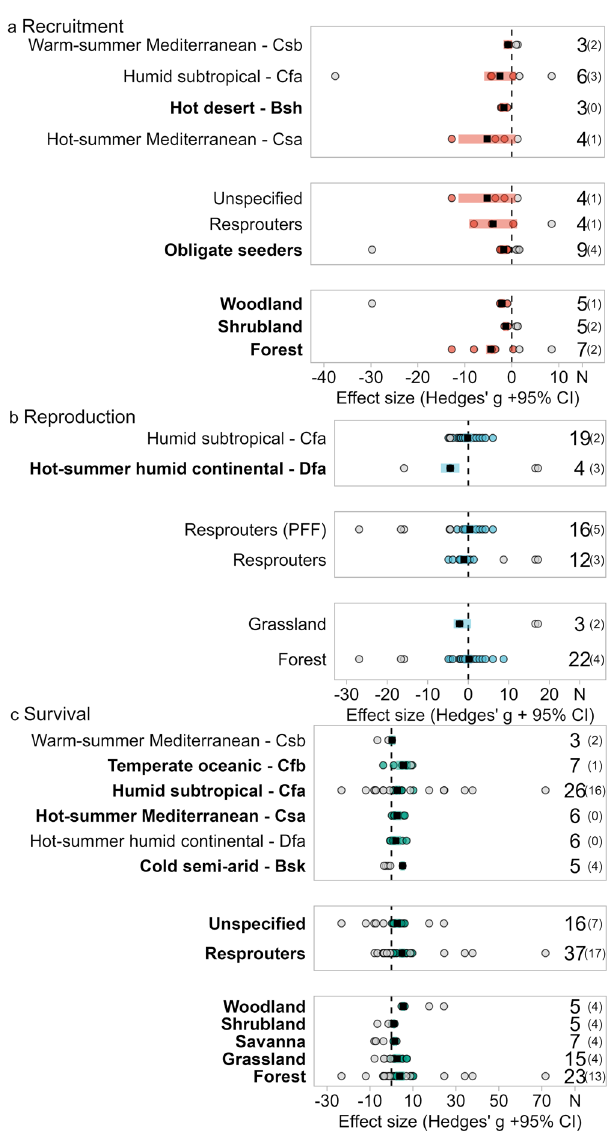
Fig. 2 Fires out of their historical temporal range affect plant species recruitment. Results of subgroup meta-analysis investigating the effects of climate type, plant functional group and vegetation type for comparisons of a recruitment b reproduction and c survival between fi res within the historical fi re season and fi res outside the historical fi re season. Modelled mean effects and 95% con fi dence intervals around the mean presented. Negative Hedges ’ g -values represent increased effects following fi res in historical fi re seasons relative to fi res outside historical fi re seasons. Positive Hedges ’ g -values represent increased effects following fi res outside historical fi re seasons relative to fi res in historical fi re seasons, coloured points represent studies within 95% CI of pooled effect size estimate and non- coloured points have been identi fi ed as outliers and excluded from analysis. N represents the sample size in each of the subgroup comparisons, numbers within parenthesis adjacent to N numbers indicate number of outliers that were identi fi ed within each analysis. Bold text indicates subgroups with signi fi cant effects. Studies where species responses were reported without reporting response traits we characterised as “ unspeci fi ed ”